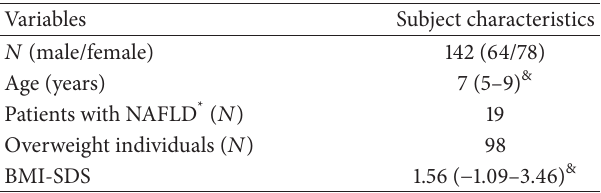
Table 1: Clinical characteristics of the pediatric cohort.